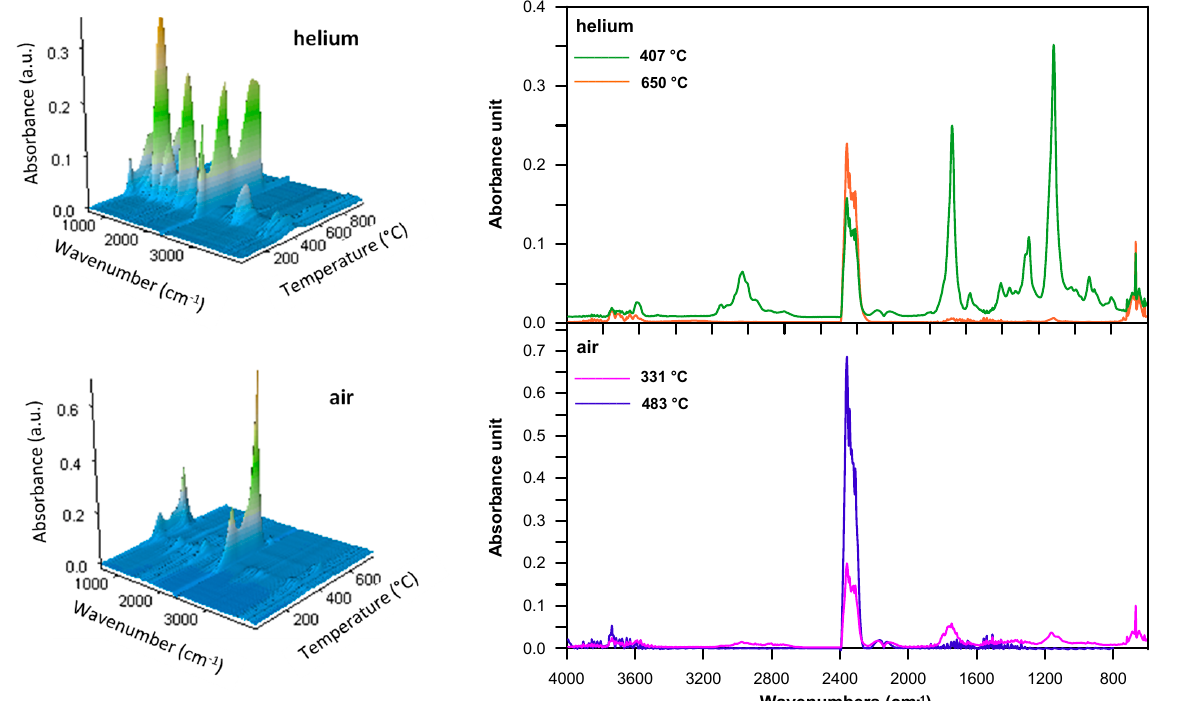
Figure 6. FTIR spectra of volatile products evolved during the thermal decomposition of DVB- co - EGDMA copolymer: 3D ( left ) and extracted at the maxima of decomposition ( right ). The DVB- co -BMPS copolymer, apart from methacrylate groups, also contained the diphenyl sulfone unit. As a consequence, additional bands pointing to the creation of sul- fur dioxide associated with stretching vibrations at 1375–1340 cm − 1 were detected in the FTIR spectra, which is clearly visible in Figure 7. In turn, the spectra received for DVB- co -